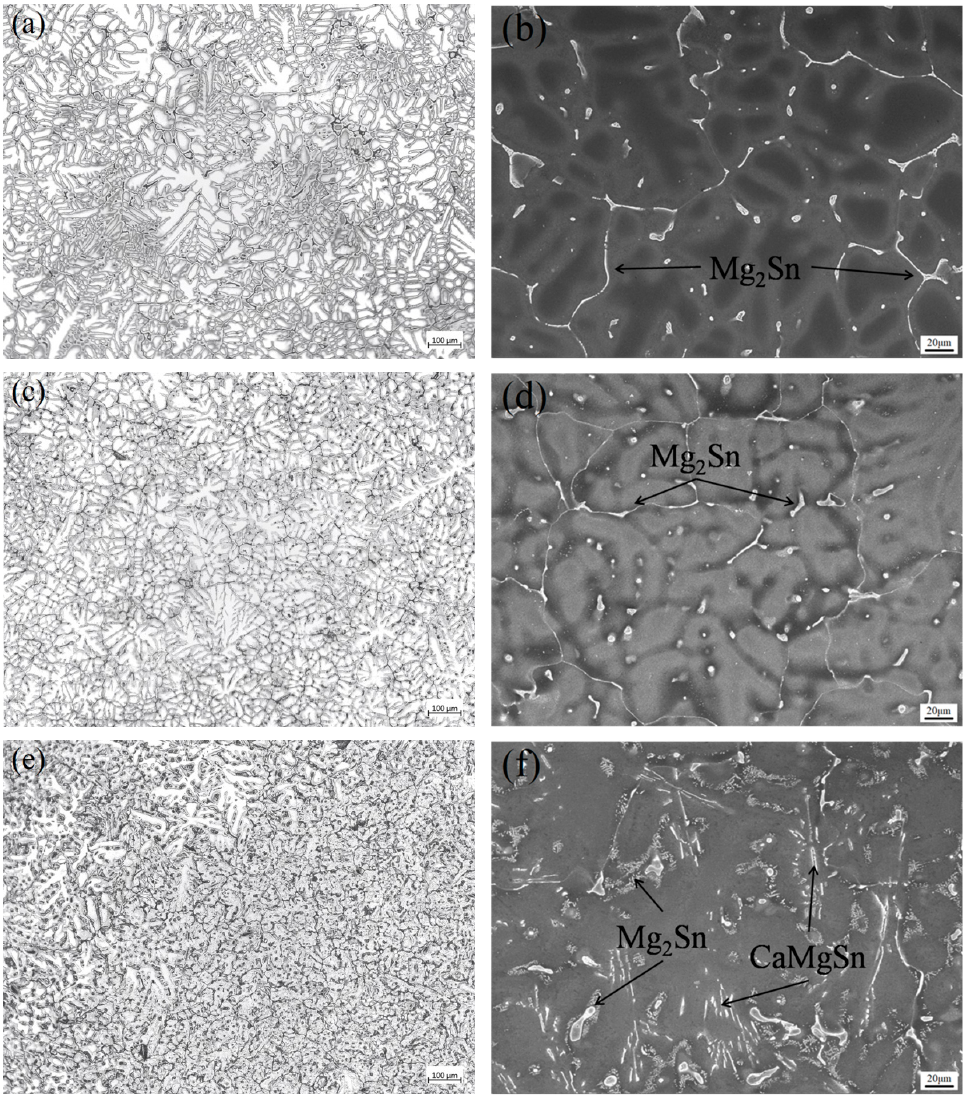
Figure 3. Optical microstructure and SEM images of as-cast samples: ( a , b ) Mg-6Sn; ( c , d ) Mg-6Sn-2Zn; and ( e , f ) Mg-6Sn-2Zn-1Ca.